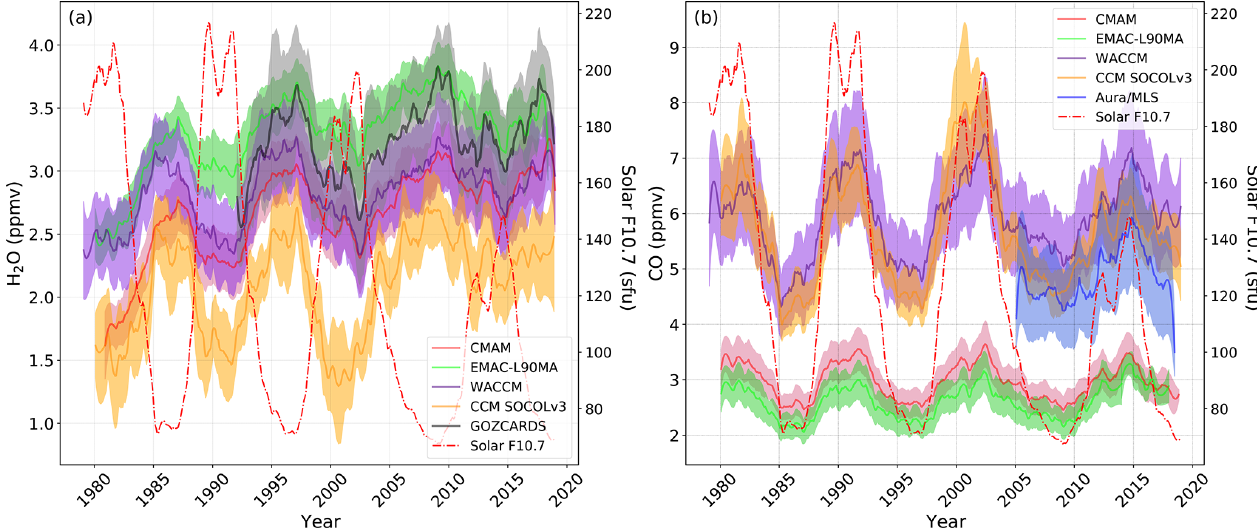
Figure 1. Time series of monthly mean (a) H 2 O and (b) CO mixing ratio from CCMI-1 models, as well as GOZCARDS observational composite (gray line and shading in a , starting in 1992) and Aura/MLS observations (blue line and shading in b , starting in 2005) at 0.01hPa averaged over the tropics (30 ◦ N–30 ◦ S). Shadings: 1 σ standard deviation. The dash-dotted red line indicates the F10.7 solar